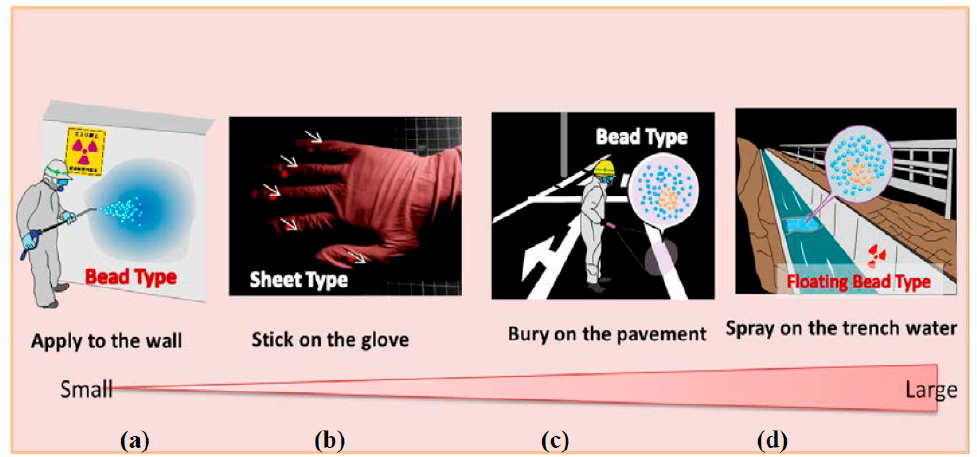
Figure 7. A schematic diagram for applications of the bead-type and sheet-type glass dosimeter in the cases such as ( a ) apply to wall, ( b ) stick on the glove, ( c ) bury on the pavement and ( d ) spray on the trench